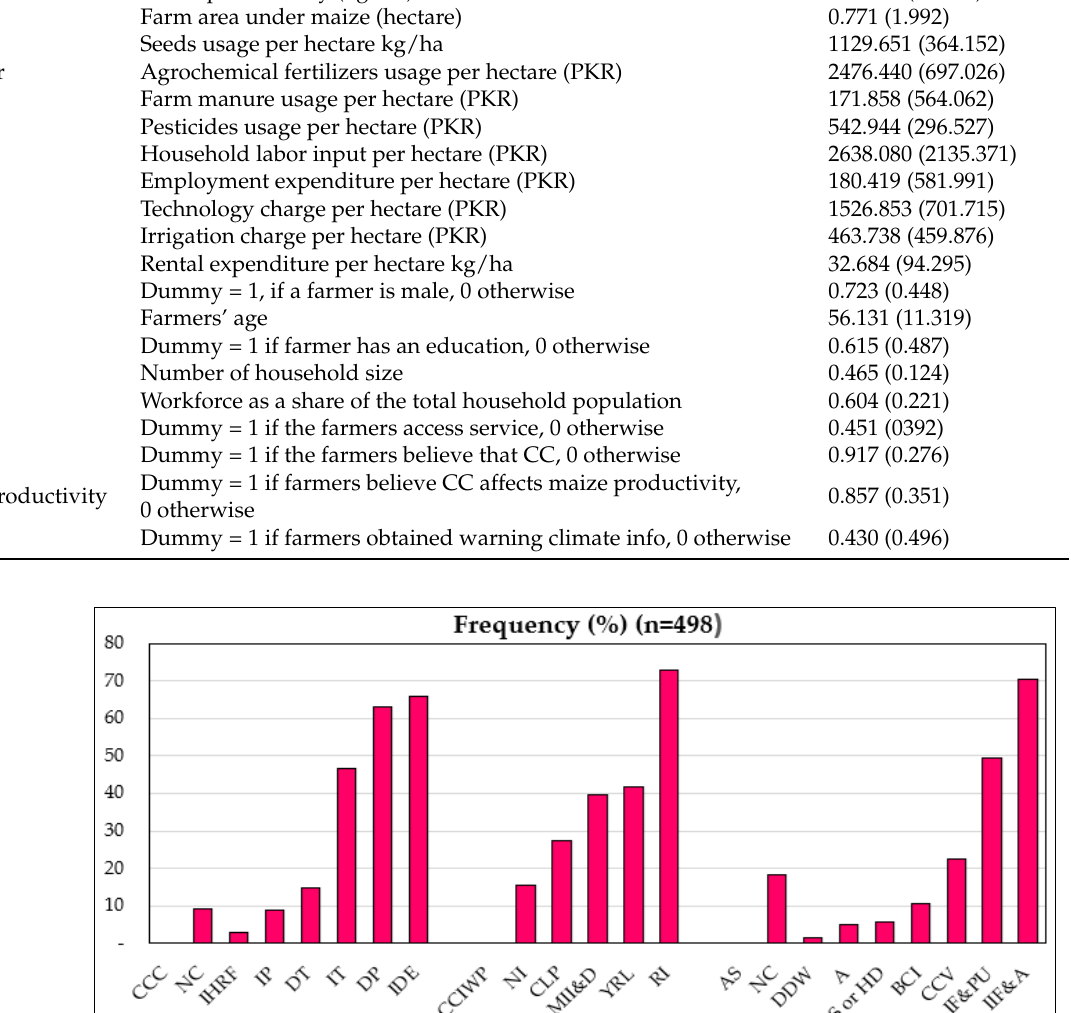
Table 2. Farmstead and farmers ’ attributes of adopters and non-adopters.